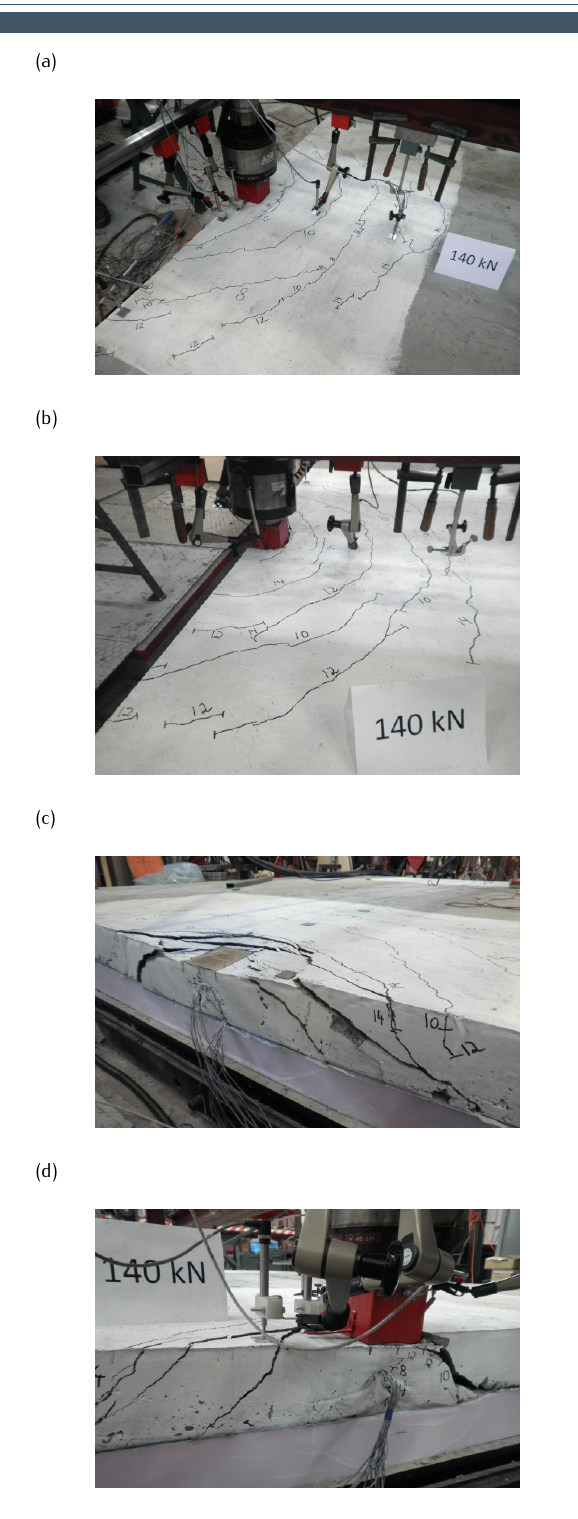
Figure 10. Crack patterns at failure loads for edge loading [15], (a) Edge load 1, (b) Edge load 2, (c) Edge load 1, (d) Edge load 2.